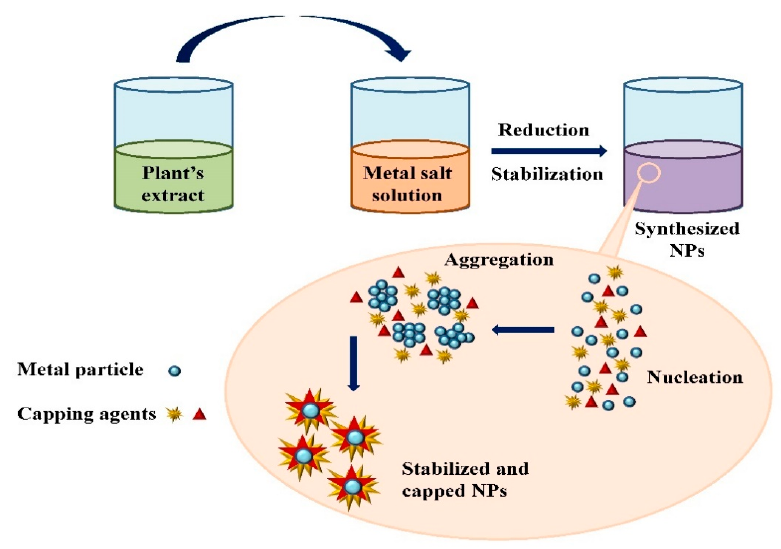
Figure 4. Mechanism of nanoparticle synthesis using phytoextracts.